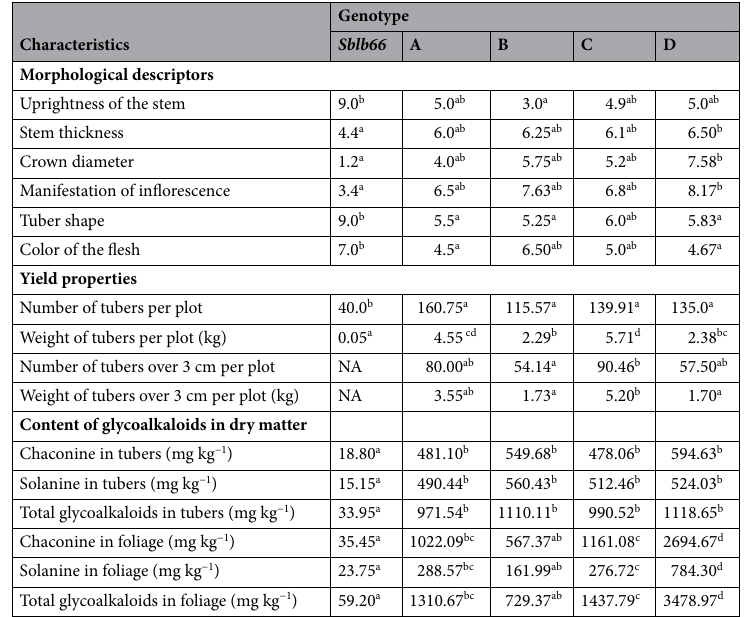
Table 3. The comparison of the ncSSR genotype groups (A, B, C, D) of somatic hybrids with parent Sblb66 in characteristics showing significant somaclonal variation ( P < 0.05). Footnotes (a, b… etc.) indicate placement of mean values into homogeneous